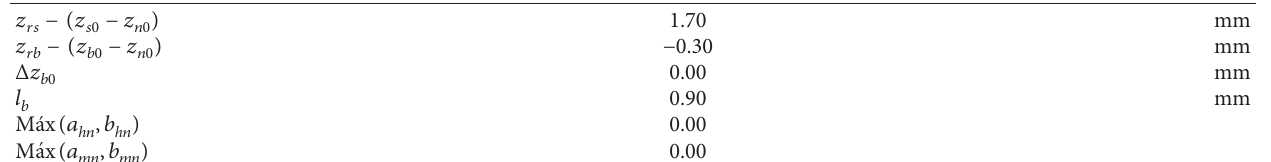
Table 2: Calculated parameters, Case